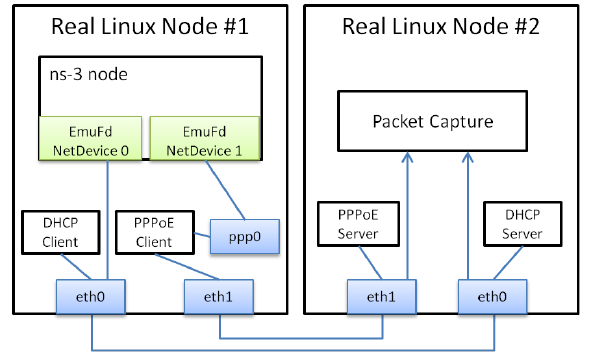
Figure 4: Laboratory testbed